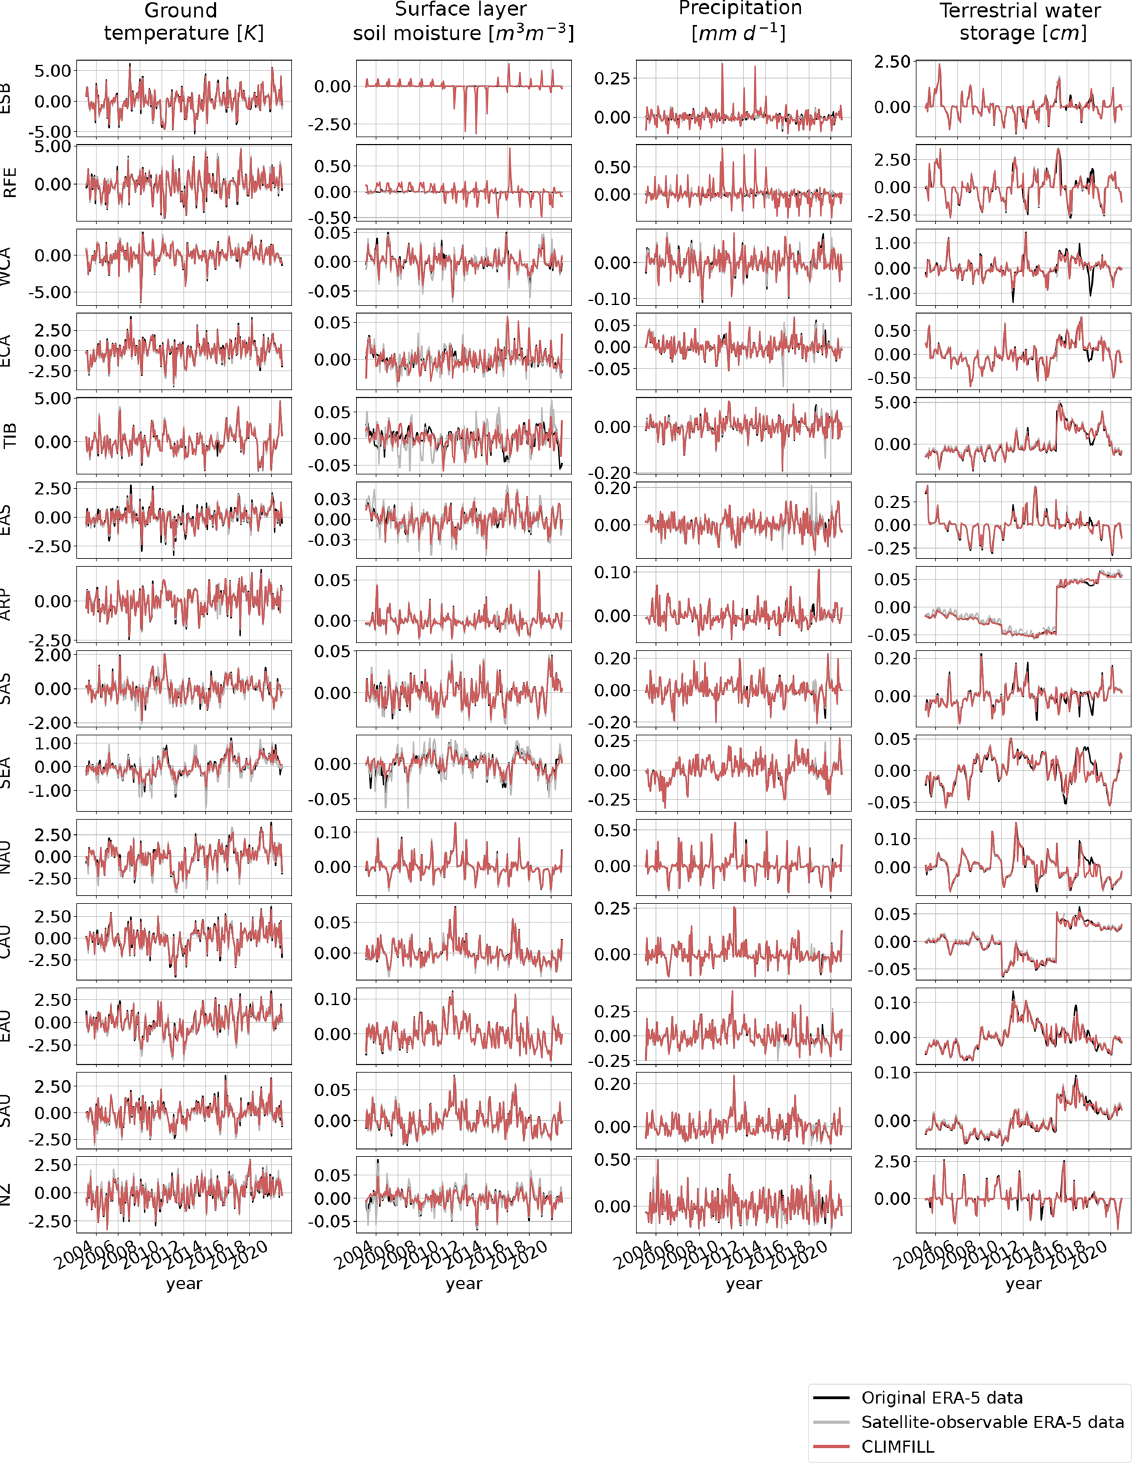
Figure A7. Figure A5